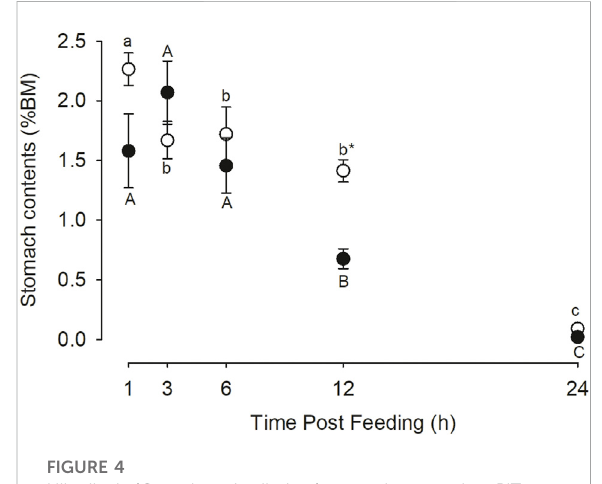
FIGURE 4 Nile tilapia ( Oreochromis niloticus ) stomach evacuation. PIT tagged Nile tilapia were fed a 1% BM ration of pellets that were either sham treated (Control; white circles) or dosed with omeprazoleat25 mg kg − 1 BM(Omeprazole;blackcircles)for 30 days. Serial dissections at fi ve selected timepoints 1, 3-, 6-, 12-, and24-hpost-feeding(n=10)wasusedtoassessgastriccontents gravimetrically. These values represent the wet mass of stomach contents as a percentage of animal body mass. Signi fi cant differencesbetween treatments wereonlyfound atthe12-h post- feeding timepoint ( p < 0.05). Time points with unshared letters are signi fi cantly different from each